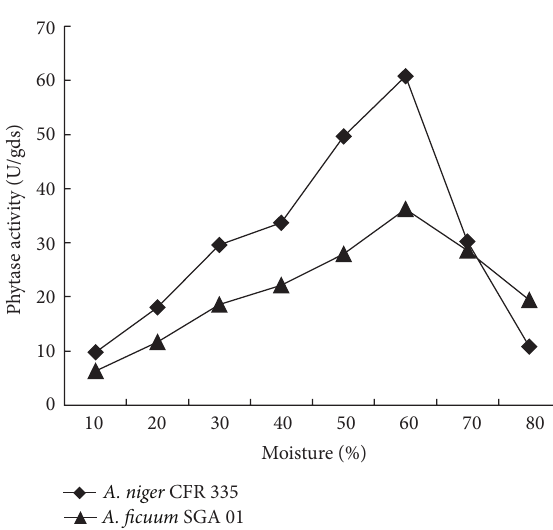
Figure 3: Effect of moisture level on phytase production by Asper- gillus niger CFR 335 and Aspergillus ficuum SGA 01 in solid-state fermentation.